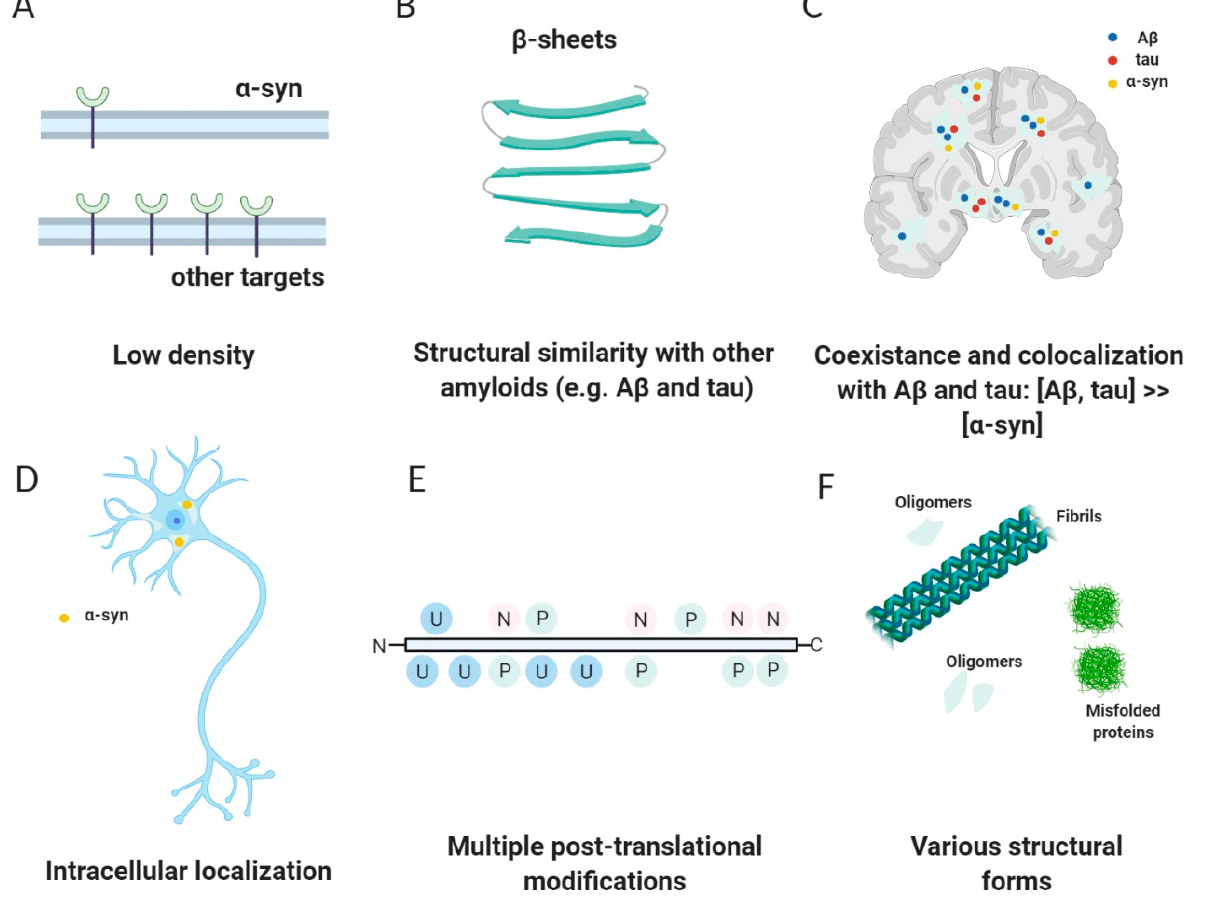
Figure 3. Challenges and characteristics of an ideal α -syn tracer. (Reprinted with permission from [56]. Copyright 2014 the Society of Nuclear Medicine and Molecular Imaging, Inc.) ( A ) Low density and concentration of α -syn in comparison with other targets. ( B ) Structural similarity with other proteins such as A β and tau. ( C ) Coexistence and colocalization with structural similar amyloids such as A β and tau. ( D ) Intracellular localization. ( E ) Multiple post-translational modifications such as phosphorylation (P), ubiquitination (U), and nitration (N). ( F ) Various structural forms such as fibrils, oligomers, and misfolded proteins. (Visualized with BioRender).